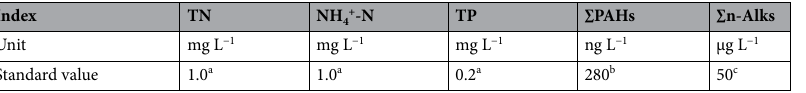
Table 1. Calculated standard values of the five single-factor pollution indexes. a The standard value of class III water in environmental quality standards for surface water in China (GB3838-2002). b One hundred times the standard value of 2.8 ng L −1 of benzo(a)pyrene (BaP) in GB3838-2002. c The standard value of class III water in petroleum hydrocarbons in